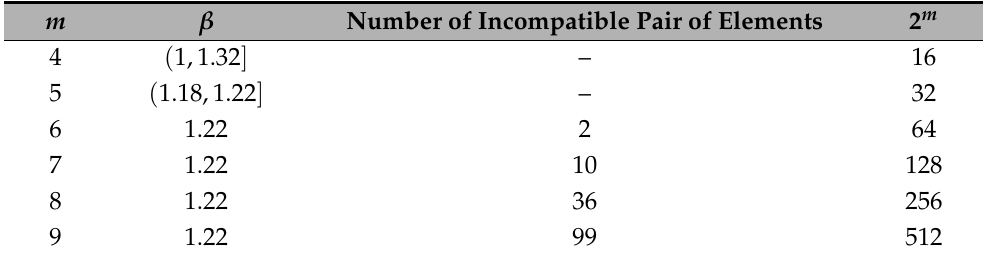
Table 5. Number of pairs ( u , v ) satisfying Avr ( β ( u ) β ( v ) ≤